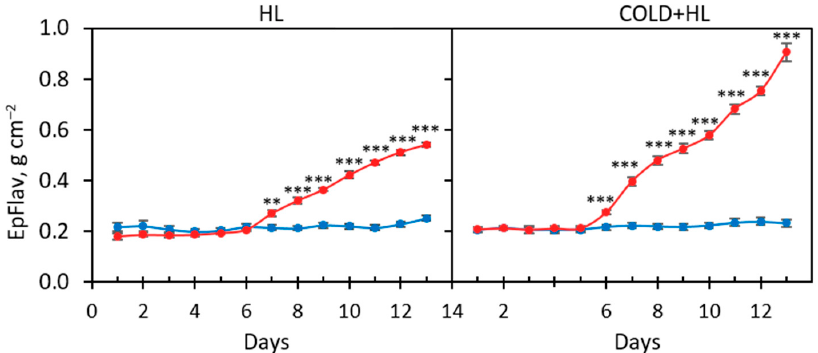
Figure 2. The change in the content of the epidermal flavonoids (EpFlav) in the GL adaxial epider- mis of P. zonale plants during a five-day pretreatment (LL) and an eight-day exposure to low light (LL, 180 µmol m –2 s –1 , blue line) and to high light (HL, 800 µmol m –2 s –1 , red line) in the HL (25 °C; left) and Cold + HL (18 °C; right) experiments. Values represent means ± SE ( HL : n = 10; Cold + HL : n = 22). Significant differences between plants treated with LL and HL, according to the t -test, are indicated in each experiment (** p < 0.005, *** p < 0.001).